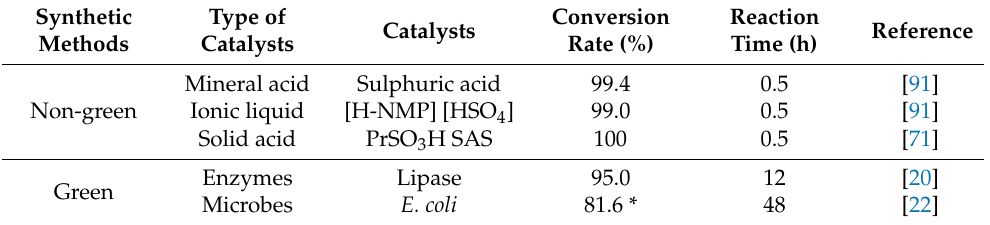
Table 1. Glycerol conversion rates achieved to date using different synthetic routes for acetins